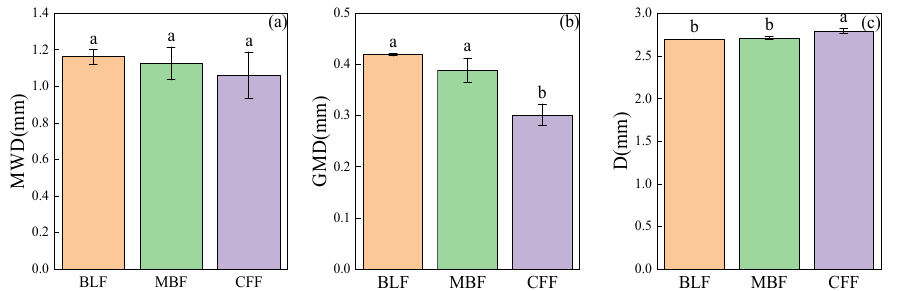
Figure 3. The comparison of the stability of aggregates in different forest types. MWD: mean weight diameter ( a ), GMD: geometric mean diameter ( b ), D: fractal dimension ( c ). Bars with different letters are significantly different ( p < 0.05). Small letters indicate changes of soil aggregate stability in three forest types with the same